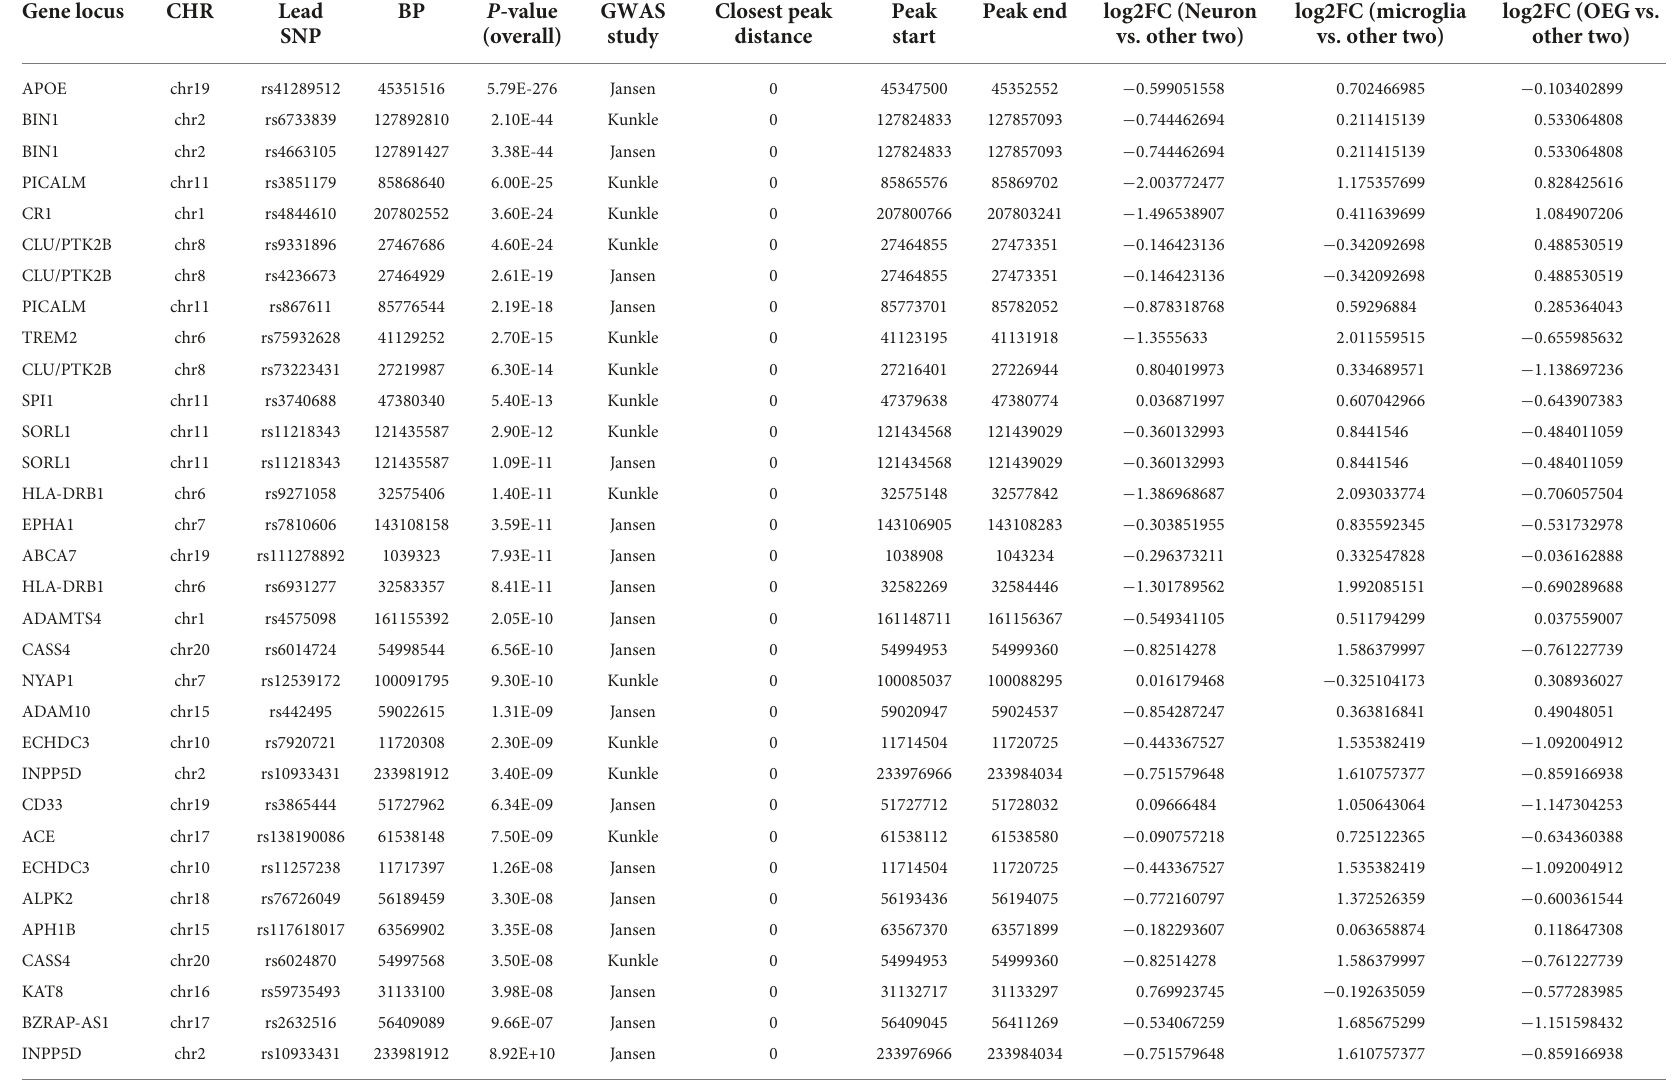
TABLE 1 Cell type specificity of peaks closest to sentinel SNPs at previously identified genome-wide significant loci from two different